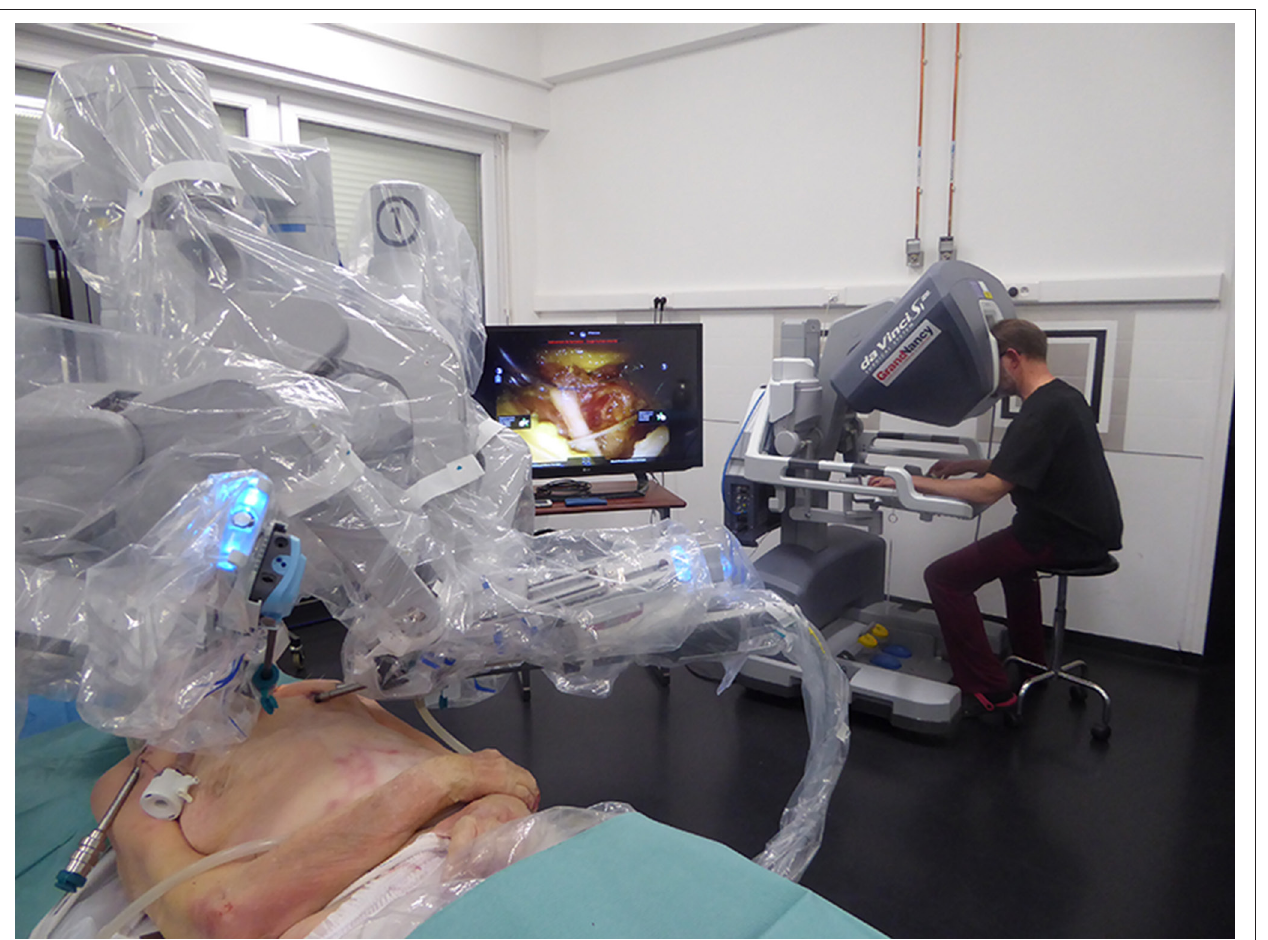
FiguRe 1 | Endoscopic robot-assisted C7 nerve root retrophalangeal transfer from the contralateral healthy side: a cadaver feasibility study. Installation of a da Vinci SI ® robot (Intuitive Surgical ™ , Sunnyvale, CA). In the first plane, the cadaver is in a supine position and the robot is installed at the head to dissect the left brachial plexus. In the second plane, a 2D monitor shows the suture of the two current C7 roots. In the third plane, the operator, installed at the surgical console, telemanipulates the robot's arms. The working space is kept open by blowing CO2 at 10